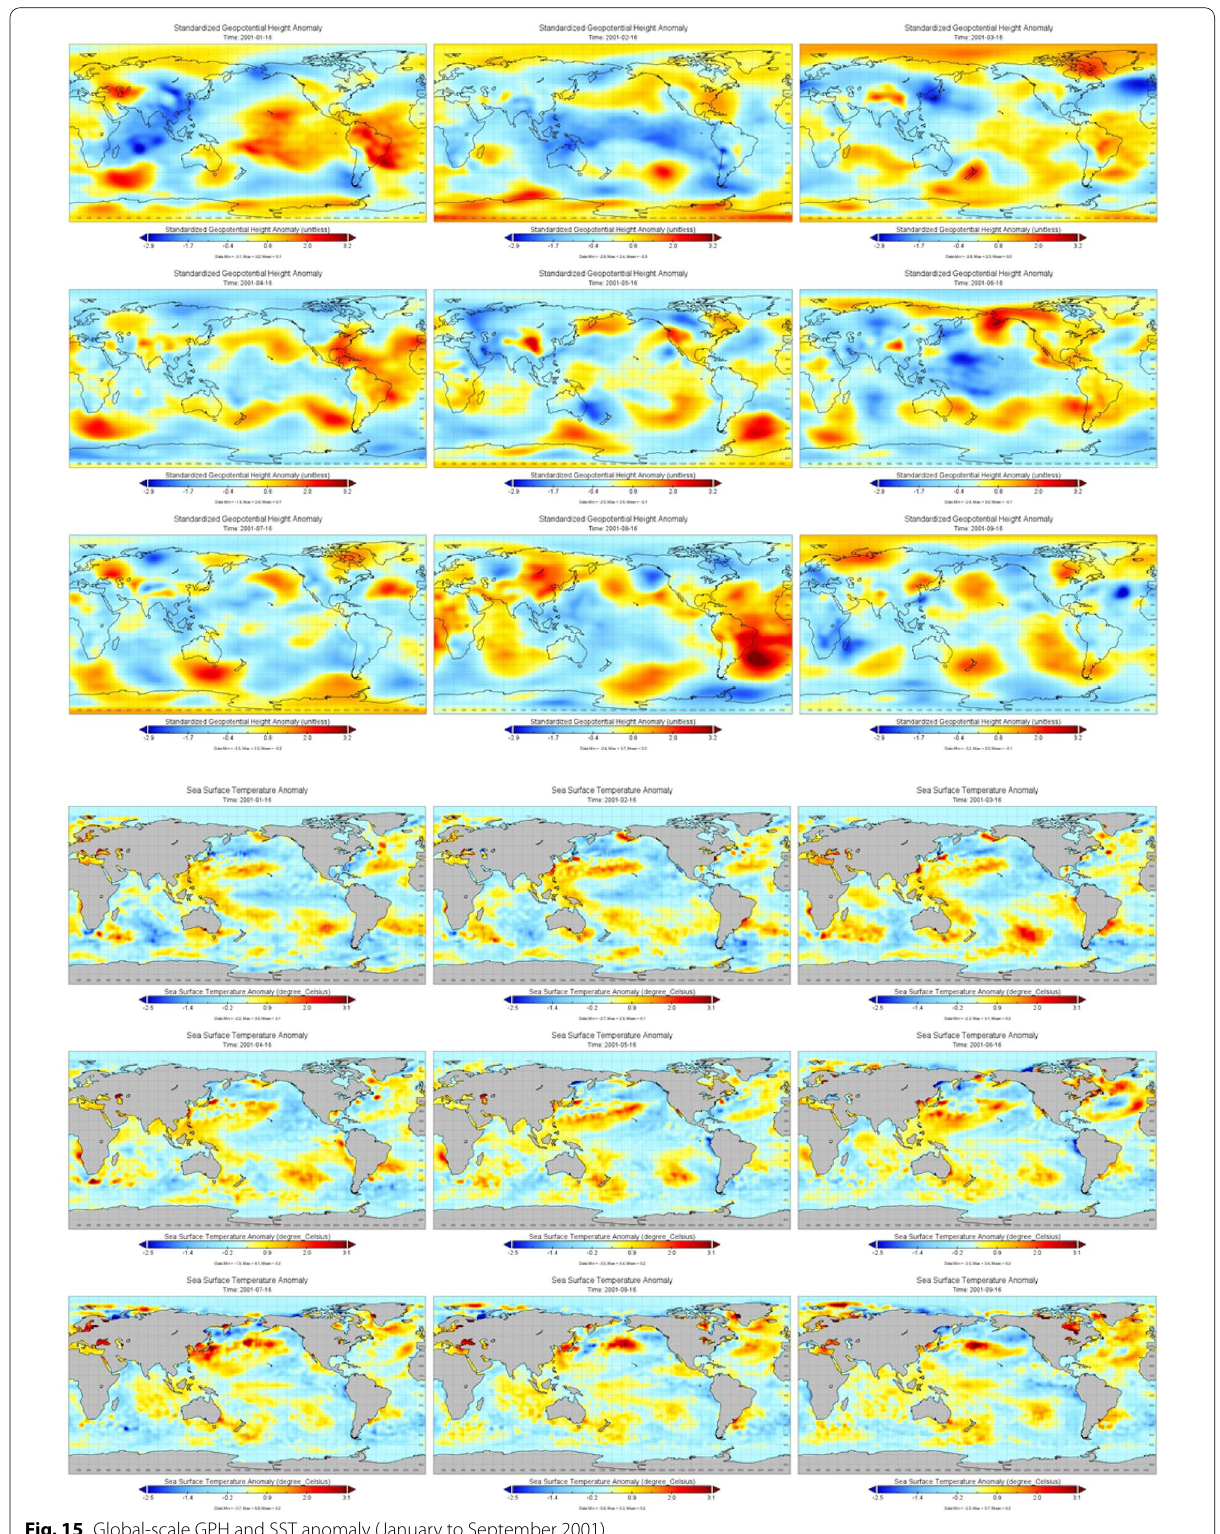
Fig. 15 Global-scale GPH and SST anomaly (January to September